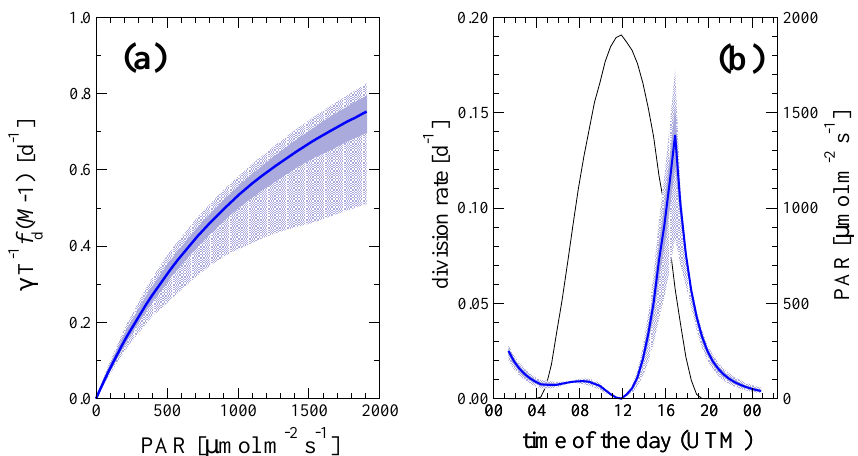
Fig. 4. Model parameters inferred for n = 1 . 06. (a) Inferred promotion rate as a function of PAR and (b) volume-average division rates as a function of hour of the day; the black line is the PAR. Thick blue line: median value; dark blue shaded area: central 68th percentile range (approximately equal to the standard deviation for normal distributions); light blue shaded area: 95% confidence